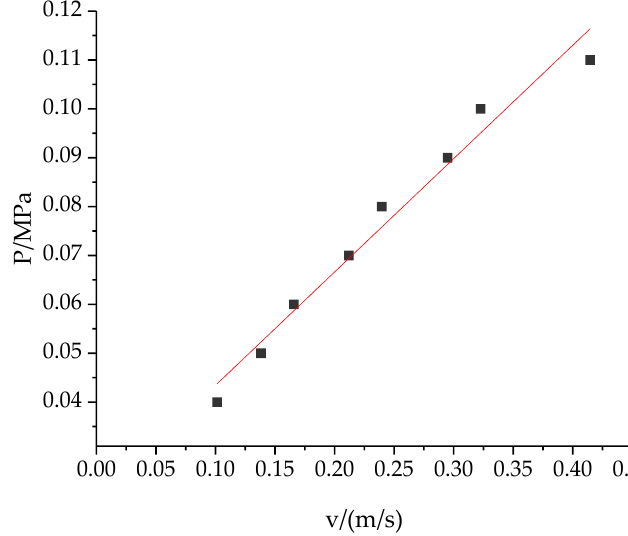
Figure 3. Fitting Curve of experimental value.